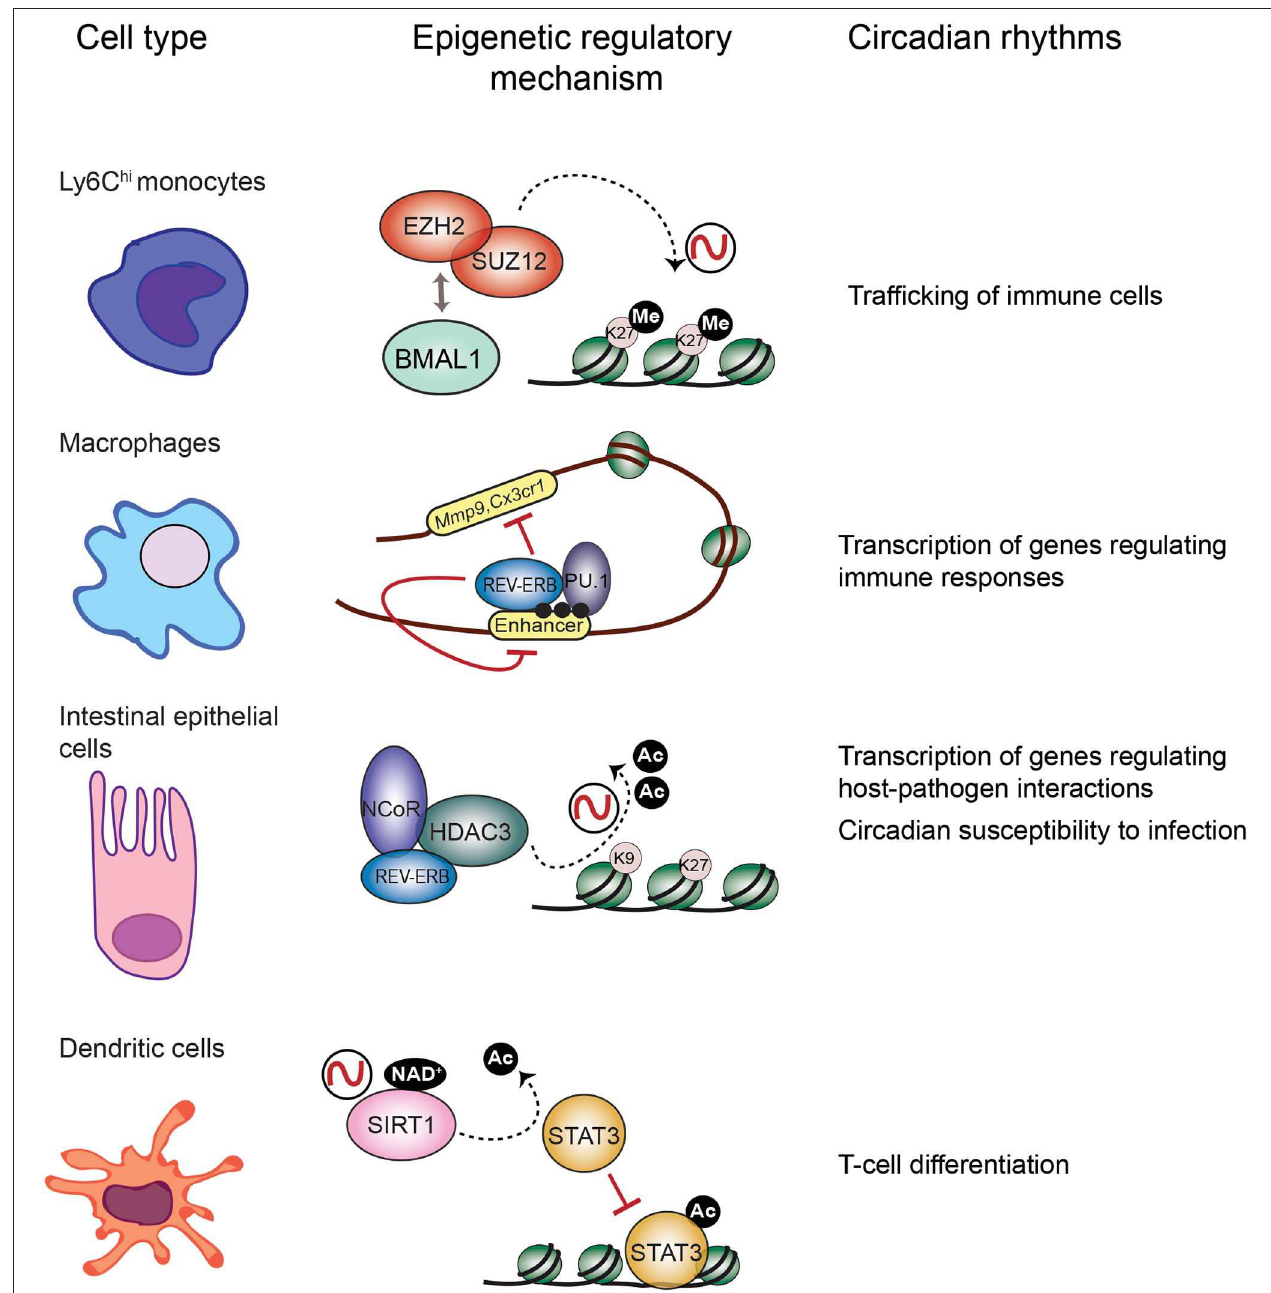
FIGURE 2 | Epigenetic regulatory mechanisms at the core of circadian function in the immune system. Circadian trafficking in the bloodstream is observed for many types of immune cells. In Ly6Chi inflammatory monocytes, circadian trafficking is regulated by an epigenetic mechanism involving molecular interactions between the circadian TF BMAL1 and the Polycomb repressive complex to regulate levels of the H3K27 methylation at the promoters of chemokine genes. In macrophages, transcription of regulatory genes appears cyclic, and the clock component REV-ERB α could be responsible by inhibiting enhancer function together with the TF PU.1, and their location is coincident with the enhancer mark H3K4me1 (black dots). Intestinal epithelial cells are components of the mucosal barrier in the gut, hence they participate in host-pathogens interactions. In these cells, the repressor complex REB-ERB α -NCoR-HDAC3 rhythmically deacetylate histones to promote chromatin compaction and cyclic silencing of genes involved in host pathogens interactions, and this mechanism could also participate in regulating circadian responses to infection. Differentiation of dendritic cells is orchestrated by the TF STAT3. The circadian HDAC SIRT1 deacetylates and inactivates STAT3, and this mechanism could be implicated in circadian regulation of differentiation and proliferation of T cells.